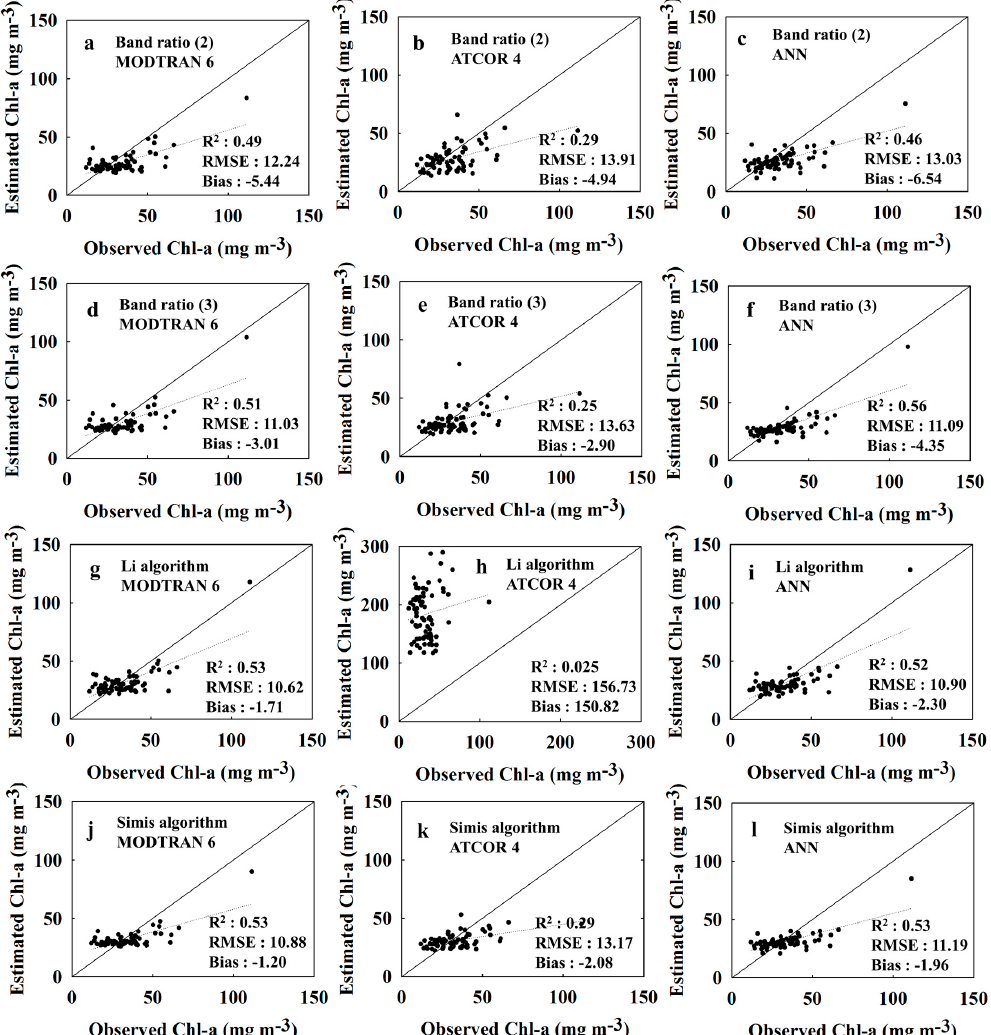
Figure 6. Optimized Chl - a algorithm results with respect to in-situ and atmospherically corrected reflectance. Panels ( a – c ) show the band ratio (2) results. Panels ( d – f ) show the band ratio (3) results. Panels ( g – i ) show the Li algorithm results. Panels ( j – l ) show the Simis algorithm results.